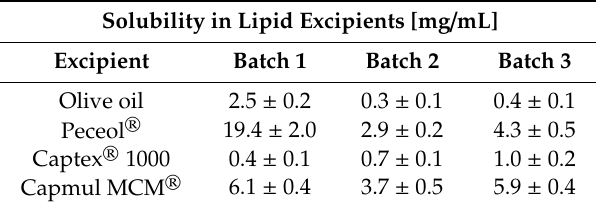
Table 3. Apparent solubility of venetoclax in lipid excipients at 37 ◦ C (mean ± SD; n =